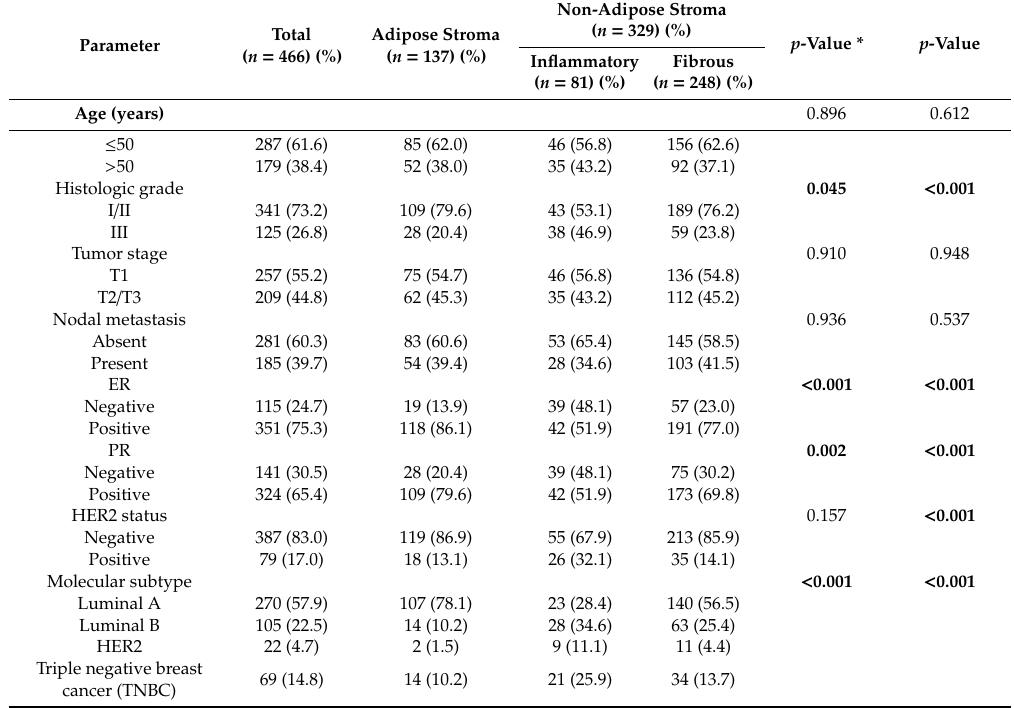
Table 2. Clinicopathologic characteristics of patients according to breast cancer stroma